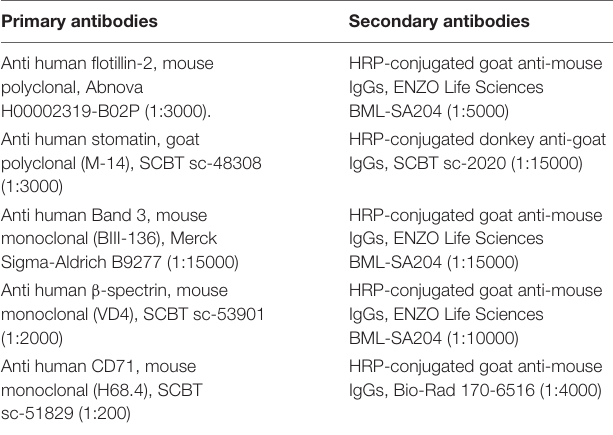
TABLE 1 | Primary and secondary antibodies used (at the dilution indicated in parentheses) for Western blotting in the present study. Primary